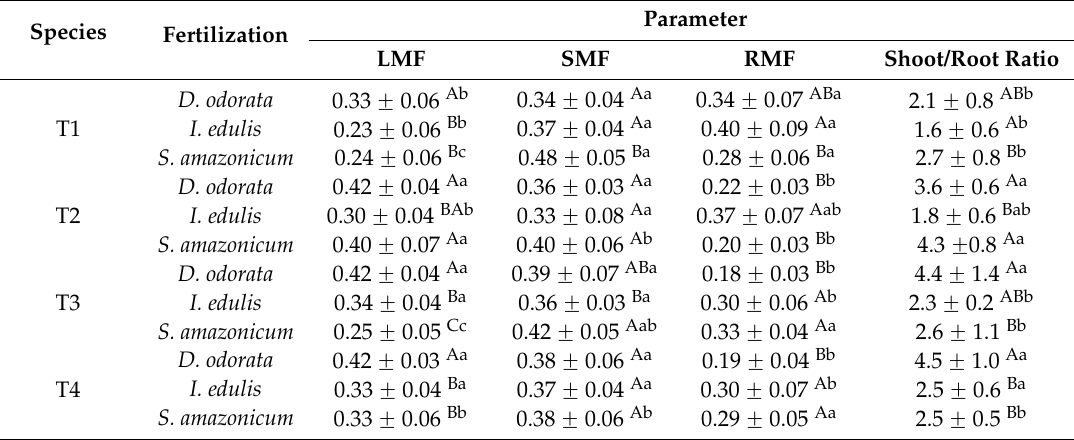
Table 5. Biomass allocation of leaves, stems and roots and the shoot-to-root ratios of three leguminous trees in all of the fertilization treatments: leaf mass fraction (LMF), stem mass fraction (SMF), root mass fraction (RMF) and shoot-to-root ratio (S/R